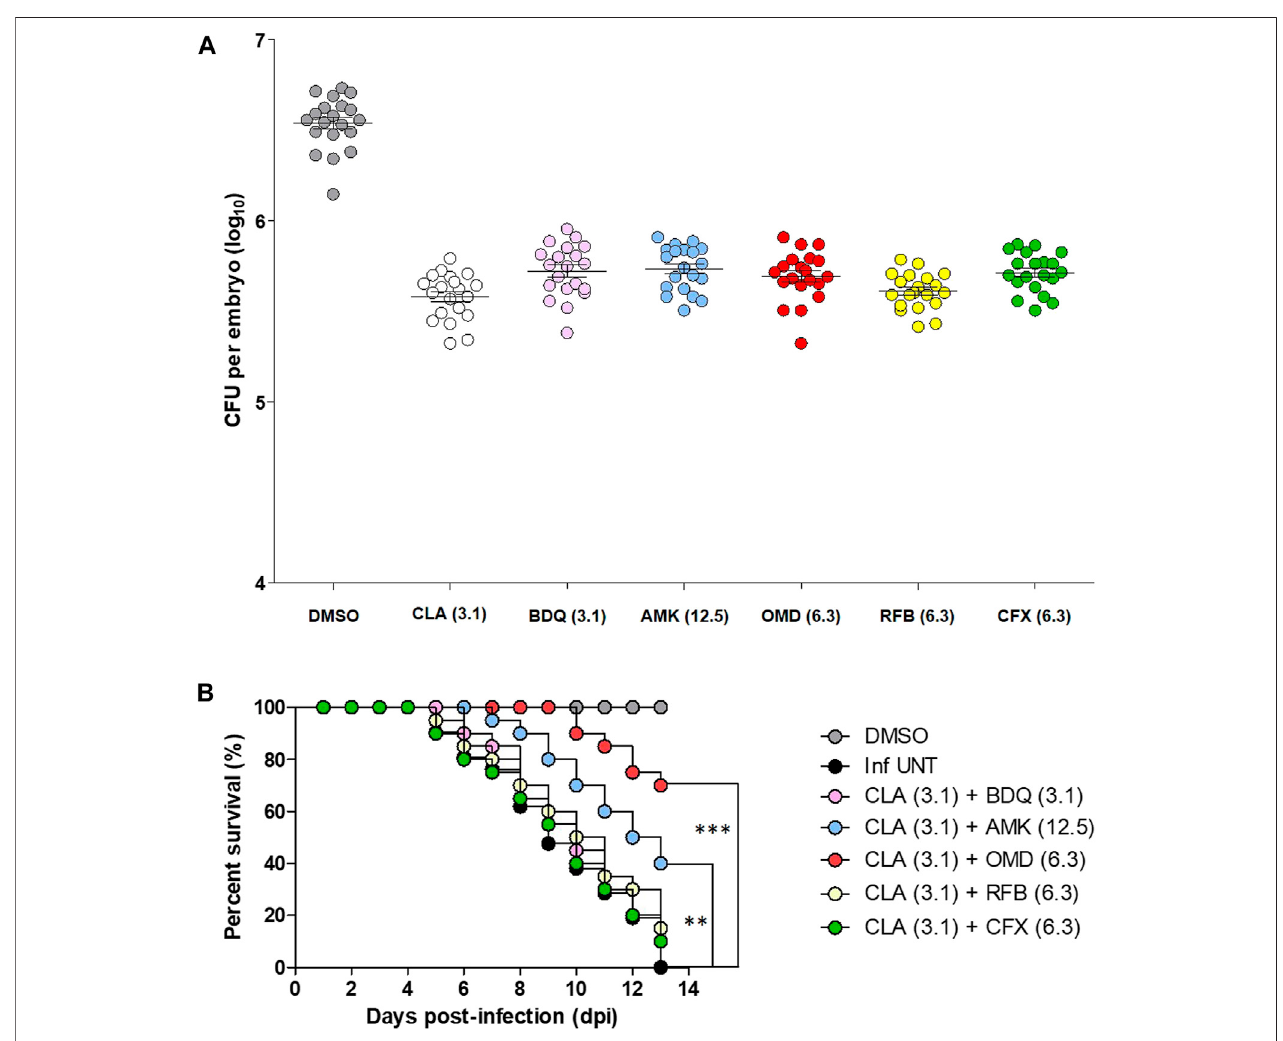
FIGURE 3 | ZF in vivo ef fi cacy of CLA-OMD. The drug concentrations that show 1 log 10 CFU reduction were determined using different concentrations of CLA, BDQ, AMK, OMD, RFB, and CFX in Mab infected ZF model (A) . To determine in vivo ef fi cacy, survival curve was plotted from Mab R-mWasabi infected ZF for 13 days ( n (cid:2) 20, representative of three independent experiments) (B) . Each different combination treatment was carried out. CLA (3.1 μ M) was combined with BDQ (3.1 μ M), AMK (12.5 μ M), OMD (6.3 μ M), RFB (6.3 μ M), and CFX (6.3 μ M) respectively. Survival curves were constructed using the log-rank (Mantel-Cox) test (** p < 0.01; *** p < 0.001). Inf UNT: Infected but not treated control. Therapeutic outcome using drug combinations was validated by traditional agar plate quanti fi cation method (C) . Data was expressed as the mean log 10 CFU per embryo ( n (cid:2) 10 of each condition) from three independent experiments. Drug combination effect was also observed using fl uorescence under microscope. Each drug combinations were treated to the ZF infected with Mab R-mWasabi and reduction of mWasabi signal in ZF was monitored under the fl uorescent microscope (D) .